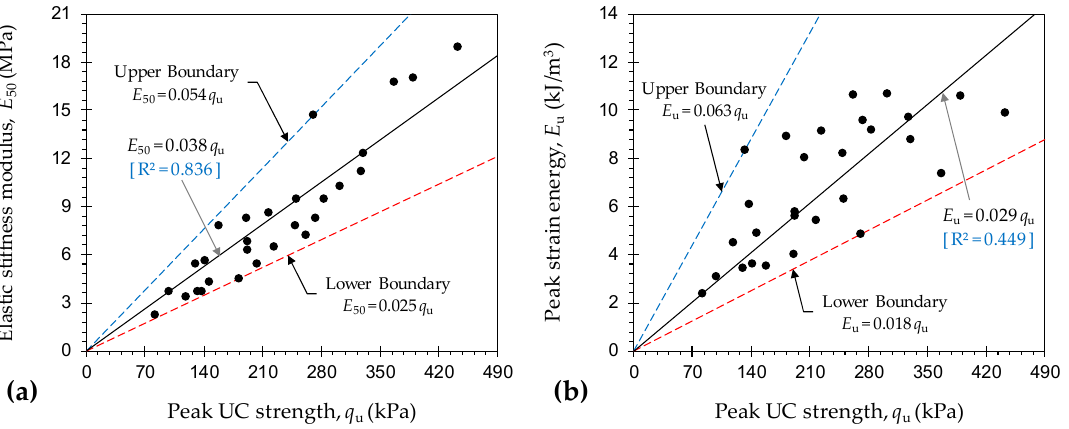
Figure 9. Variations of ( a ) E 50 and ( b ) peak strain energy E u against peak UC strength q u for various JF + GBFS blends.